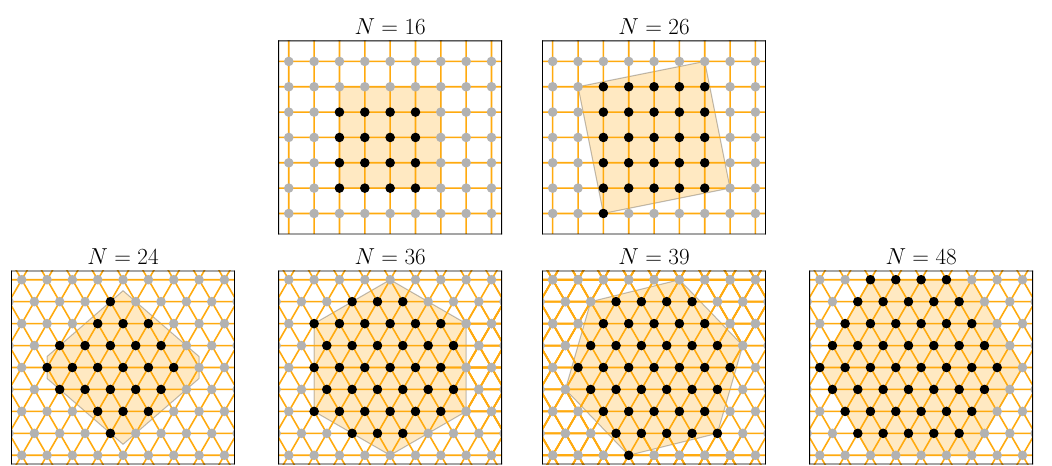
Figure 6: Some of the finite-size clusters used in the simulations. The top (bottom) row shows square (triangular) clusters. The black dots are the sites of the finite-size clusters, the yellow background illustrates the Wigner-Seitz cell. The yellow lines indicate the nearest-neighbor